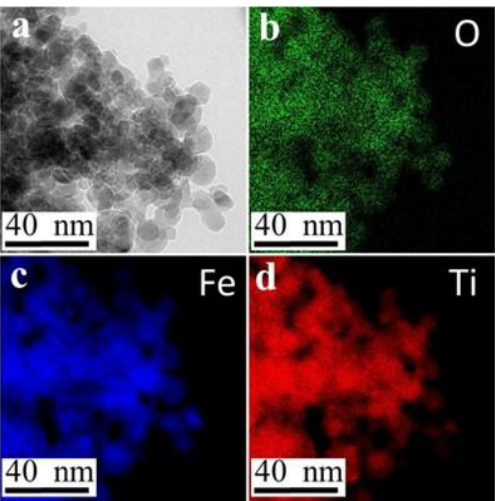
Figure 7. Elemental mapping of 10% Fe in TiO 2 nanoparticles indicating ( a ) raw TEM image, ( b , c , d ) are (O, Fe, and Ti) elemental maps, respectively.